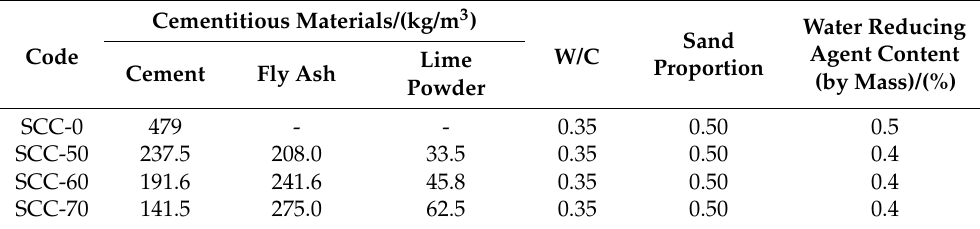
Table 4. Mix proportion of SCC containing high level fly